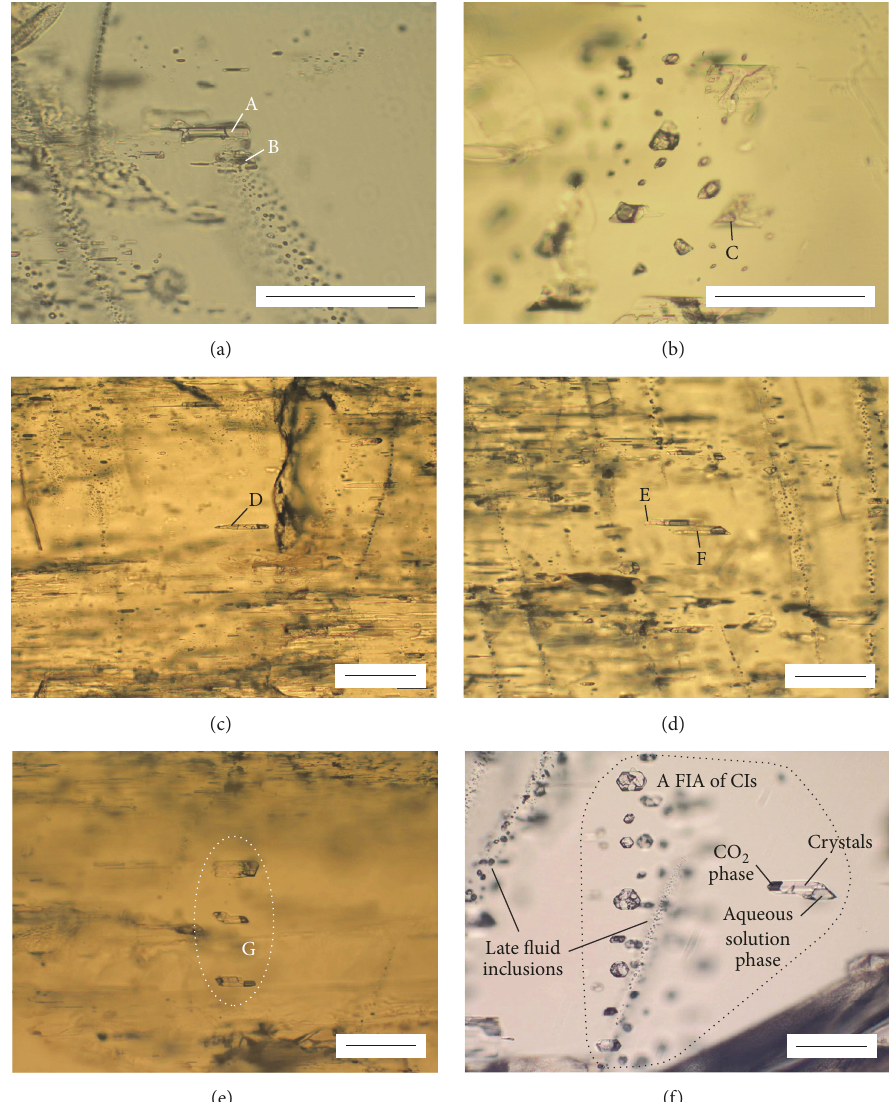
Figure 4: The fluid inclusions and crystal-rich inclusions hosted in spodumene. (a) shows the alterations of crystal-rich inclusions (CIs) “A” and “B” by the late aqueous fluid. In (b), except CI “C” that was destroyed by late fluid, other CIs occurred in one fluid inclusion assemblage (FIA) showing similar crystal/fluid proportion and CO 2 volume%. In (c), an isolated CI “D” showed primary features without alteration by late fluid. In (d), the CIs “E” and “F” belong to a FIA with similar crystal/fluid proportions and CO 2 volume% and without alteration by late fluid, which occurred along the nearby healed fractures. (e) shows that three CIs belong to a FIA “G.” (f) shows a FIA of CIs with similar crystal/fluid proportion that was cut by small aqueous fluid inclusions distributing along healed fractures. The CIs have a negative spodumene crystal-shape. The length of the scale bar in black is 100 𝜇